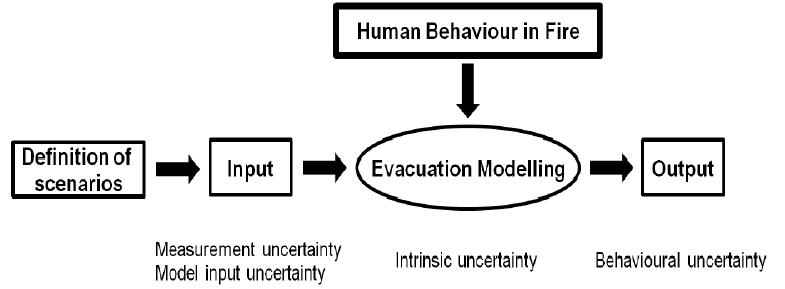
Figure 2. An evacuation flow model based on defined scenarios and human behaviour [4].